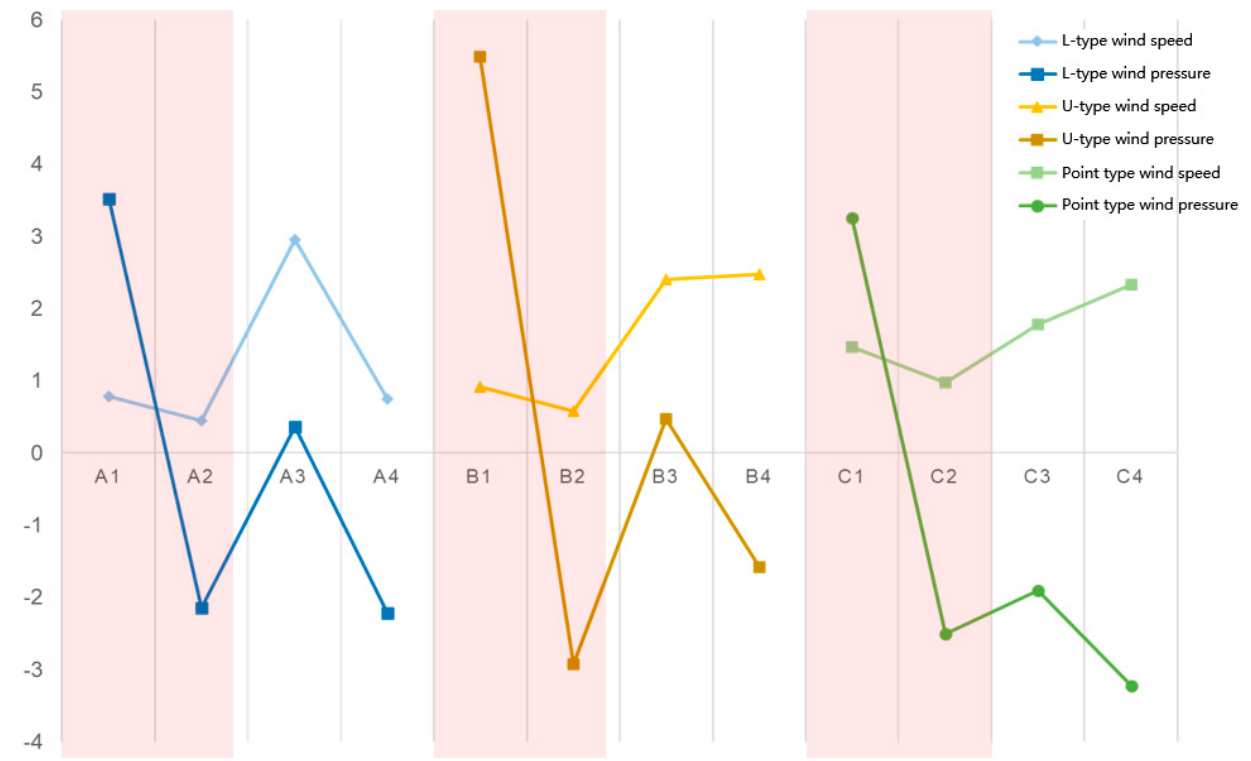
Figure A11. Wind speed/wind pressure comparison at each point.